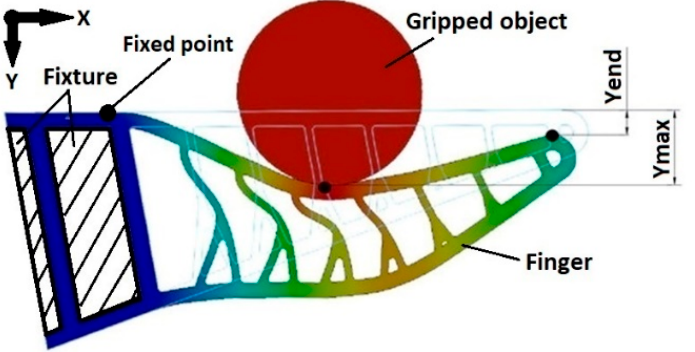
Figure 1. Measured distances on